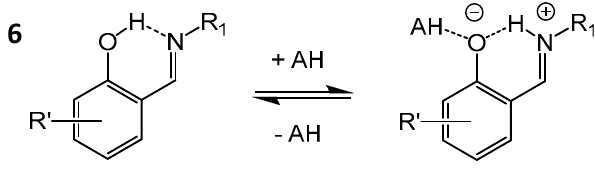
Figure 4. Schematic structure of ortho -hydroxyaryl Schiff bases, studied by NMR in [46].